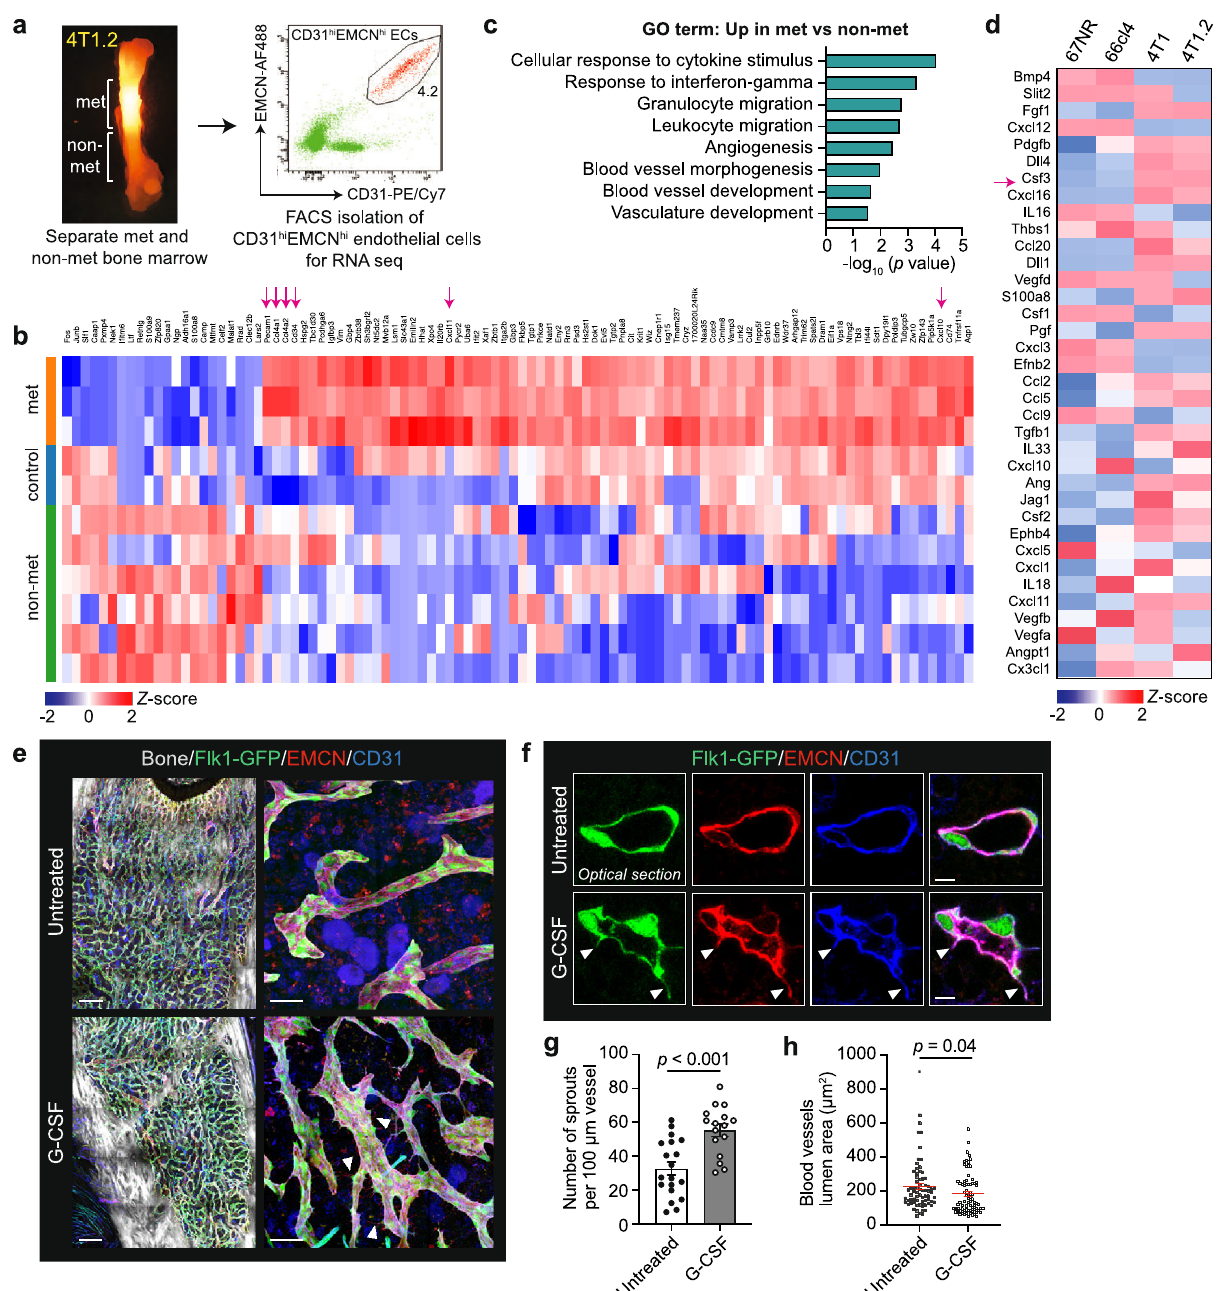
Fig. 4 G-CSF induces vascular remodelling in bone marrow. a Tumour-in fi ltrated (met) and adjacent tumour-free (non-met) areas were microdissected and sorted to isolate CD31 hi EMCN hi endothelial cells (ECs) for RNA-seq. Bones from age-matched, healthy BALB/c mice were collected as controls. Representative FACS plot showing the gating pro fi le (see Supplementary Fig. 3a). b Expression levels of top differentially expressed genes in CD31 hi EMCN hi ECs retrieved from met and non-met areas and control bones. The heat map shows the mean-centred z -score ( n = 3 (met), 2 (control) and 6 (non-met) samples). Arrows designate angiogenesis or in fl ammatory response-related genes. c Gene ontology analysis conducted on the transcriptomes of CD31 hi EMCN hi ECs isolated from met and non-met areas. d Heat map shows the mean-centred z -score of selected genes in angiogenesis and the in fl ammatory response across four isogenic murine mammary tumour lines. Genes were ranked by false discovery rate (FDR; n = 2 replicates per cell line). e Left: multiphoton 3D images of femoral BM of Flk1-GFP (green) reporter mice following G-CSF treatment. Bones were immunostained for EMCN (red) and CD31 (blue). Bone collagen was de fi ned by second harmonic signal (grey). Right: high-magni fi cation images of marrow endothelium in the corresponding mice ( n = 3 mice per group). Arrowheads mark protruding vascular sprouts. See also Supplementary Movies 4 and 5. Scale bars, 200 µ m (overviews), 20 µ m (enlargements). f Optical sections of marrow endothelium from ( e ). Arrowheads mark protruding vascular sprouts. Scale bars, 5 µ m. g , h Number of endothelial sprouts per 100 µ m of vessel length ( g ) and vessel lumen area ( h ) from ( e ). Individual dots are from one vessel. n = 3 mice per group. P values, two-tailed unpaired t tests. All data re fl ect mean ± s.e.m. Source data are provided as a Source Data fi le.